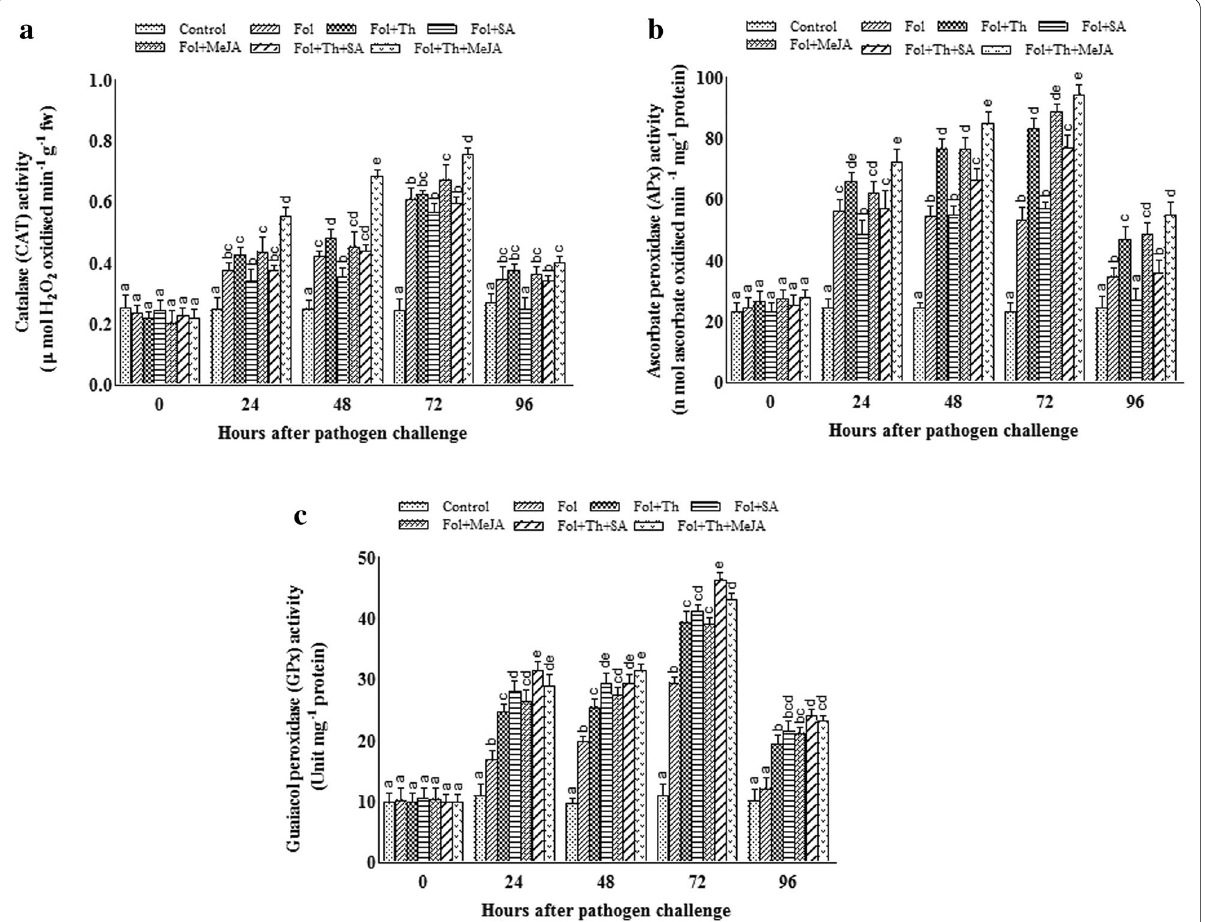
Fig. 6 Estimation of changes in the activities of a CAT, b APx, and c GPx in leaves of tomato plants pre-treated with T. harzianum , SA and MeJA either individually or in combination after challenge inoculation with Fusarium oxysporum f. sp. lycopersici (Fol). Results are expressed as the mean of three replicates and vertical bars indicate SD of the mean. Different letters indicate significant differences among treatments within the results taken at the same time interval according to Duncan’s multiple range test at p ≤